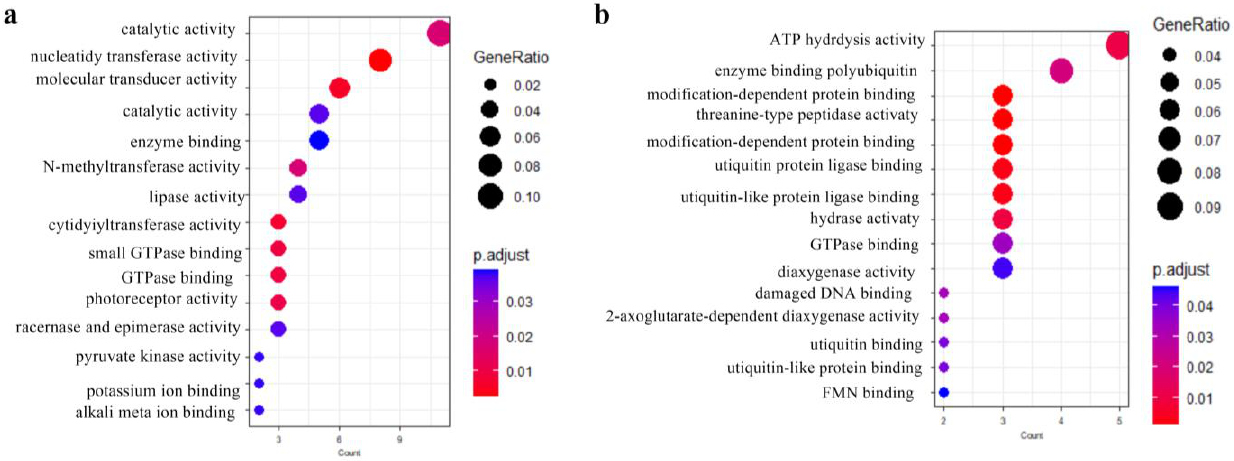
Figure 5. GO analysis of proteins encoded by candidate genes for six key kernel traits. Note: ( a ) enrichment by candidate genes for embryo and endosperm traits. ( b ) enrichment by candidate genes for cavity traits.